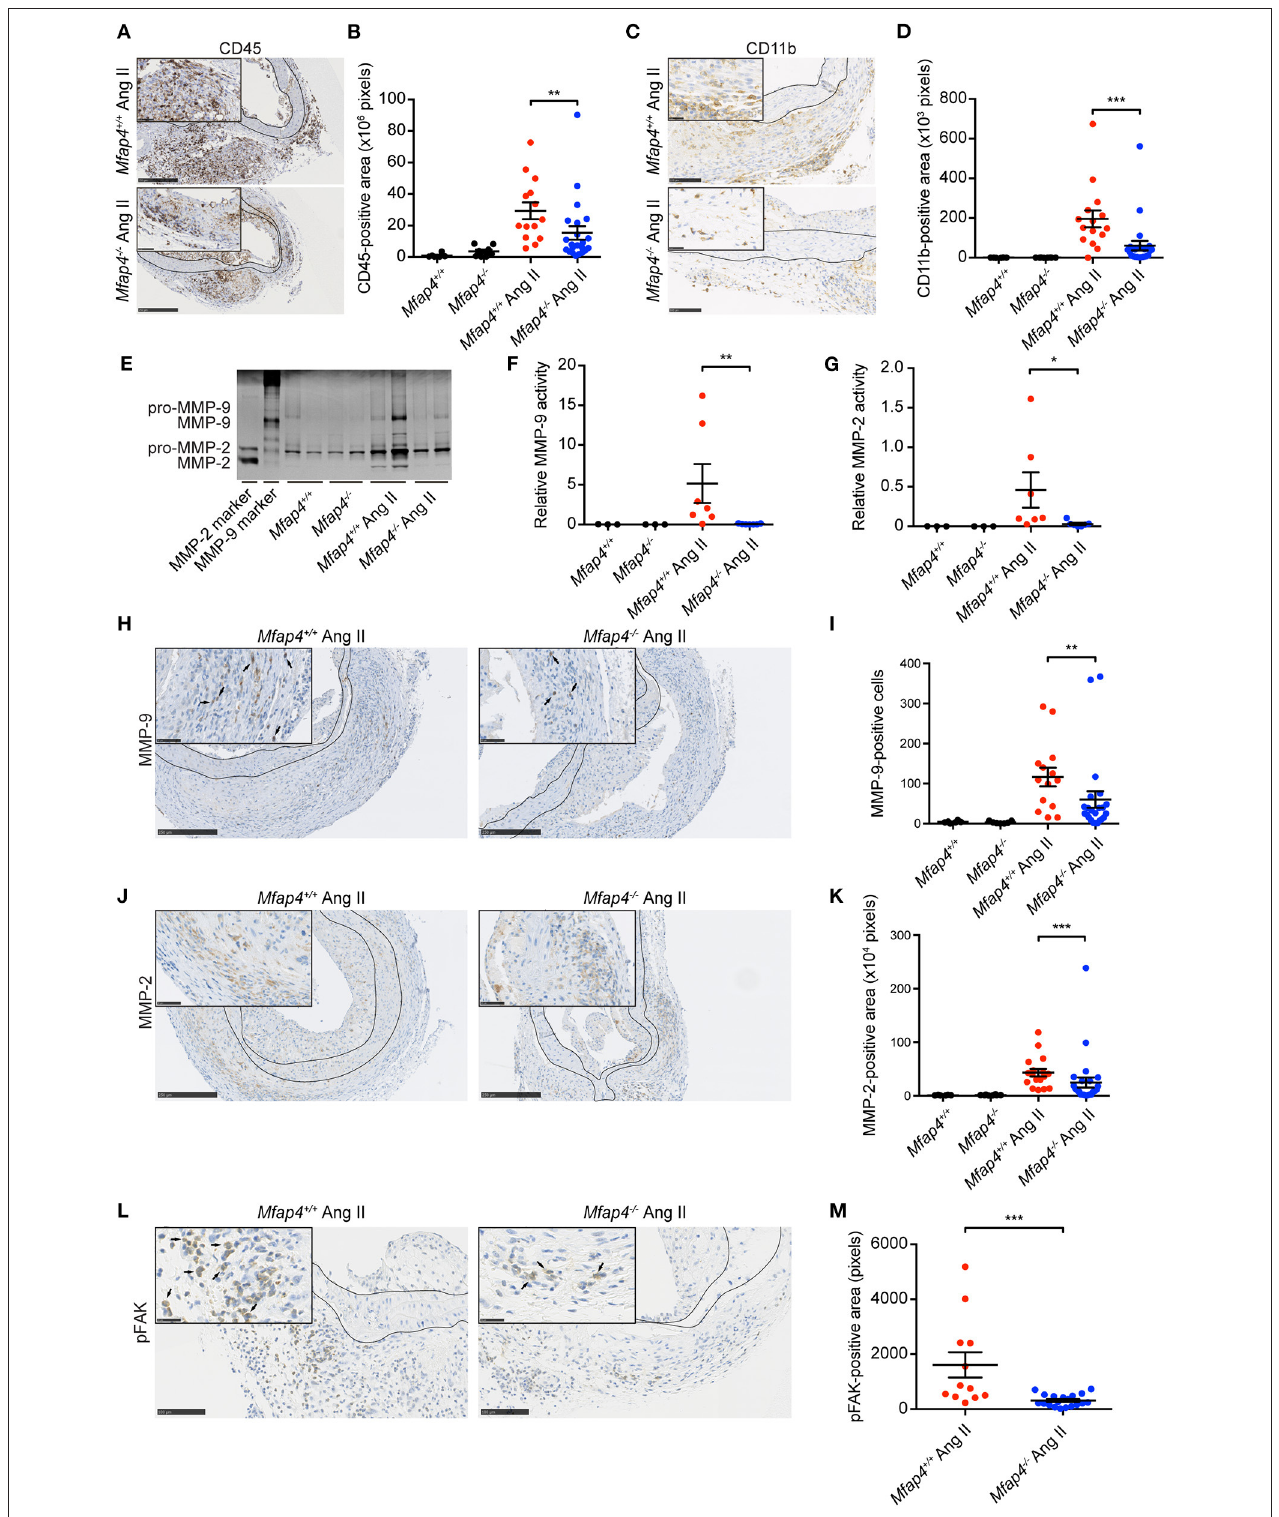
FIGURE 3 | Mfap4 deficiency reduces macrophage infiltration, MMP activity, and FAK activation in Ang II-induced AAAs. (A–D) Morphometric analysis of (A,B) CD45 and (C,D) CD11b stainings of aortic sections of ApoE − / − ( Mfap4 + / + ) and ApoE − / − Mfap4 − / − ( Mfap4 − / − ) mice after 28 days of Ang II infusion. n = 6–8 (saline),